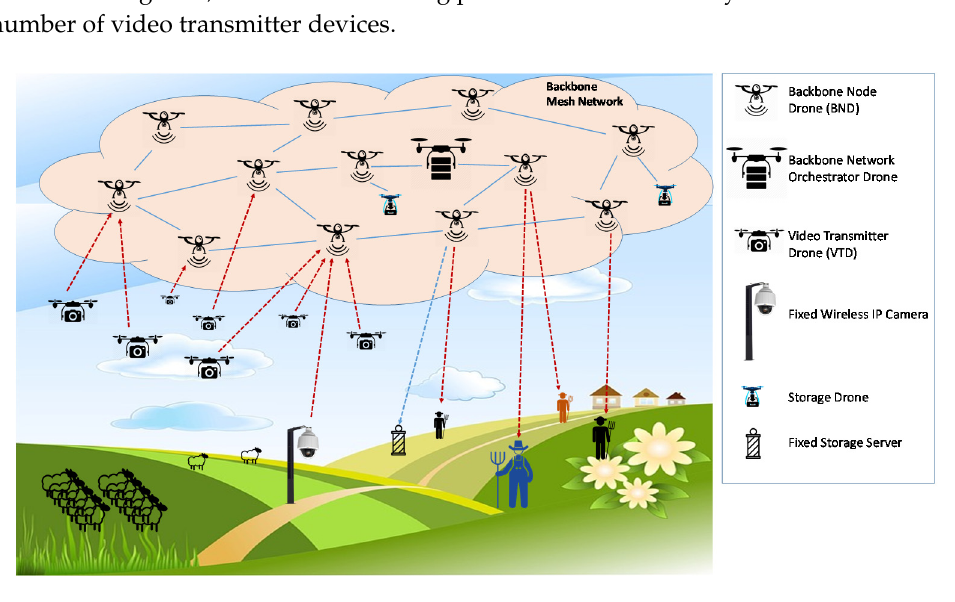
Figure 1. Reference scenario.